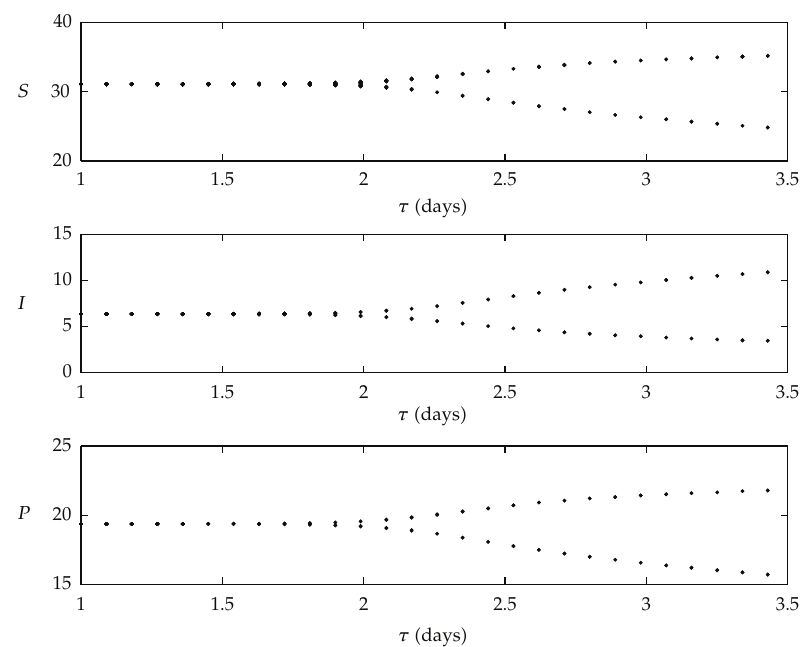
Figure 4: Bifurcation diagram of the susceptible prey, infected prey and predator populations with respect to the delay τ . Parameters are as in Figure 3 (cid:7) b (cid:8) . This figure shows that the coexisting equilibrium E ∗ is stable if τ < τ 0 (cid:5) 2 . 3187 and unstable if τ > τ 0